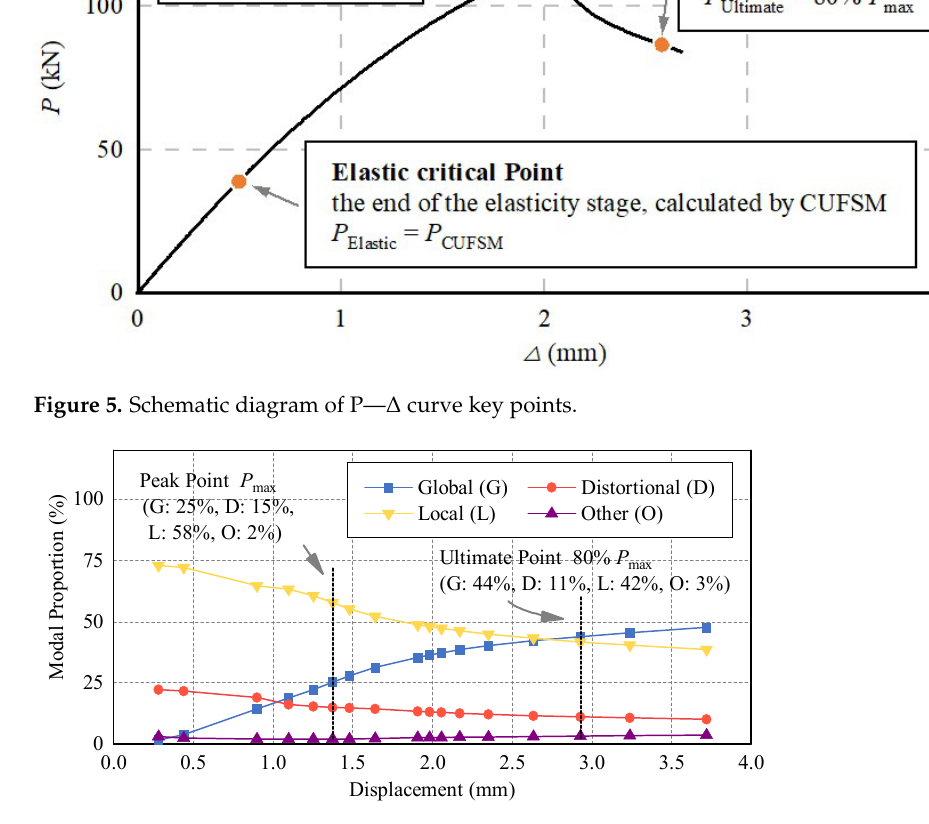
Figure 7. Full range modal participation of member FE simulation (member cross-section parame- ter is No.1, 2 mm thick, 600 mm long).